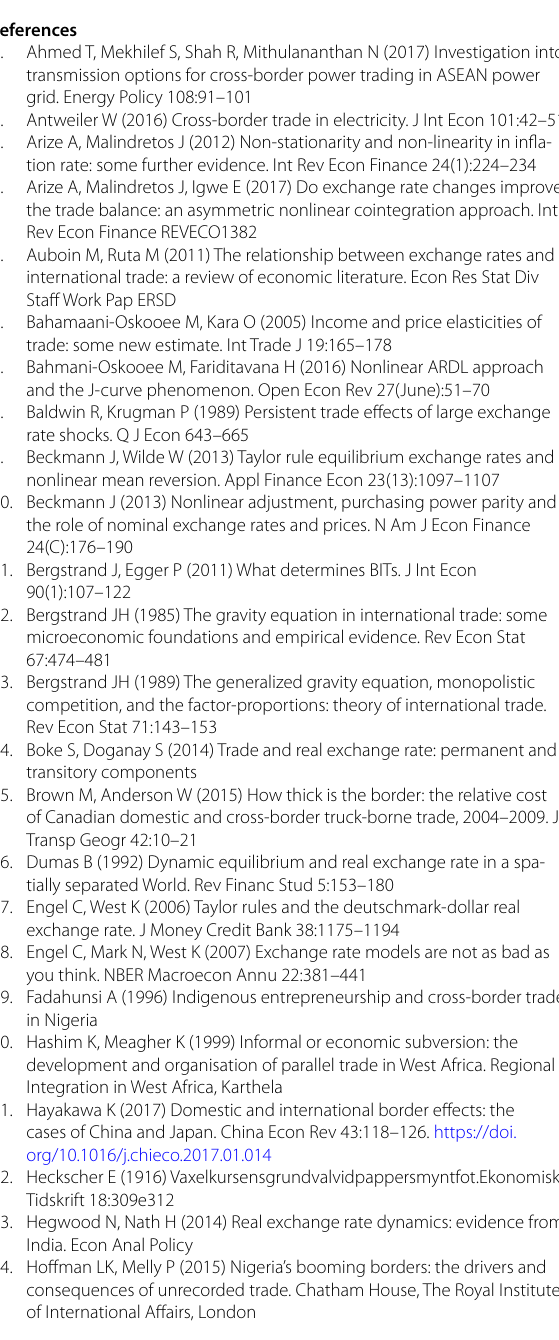
Table 2 Testing for the presence of asymmetry Source : Author’s computation based on e-views